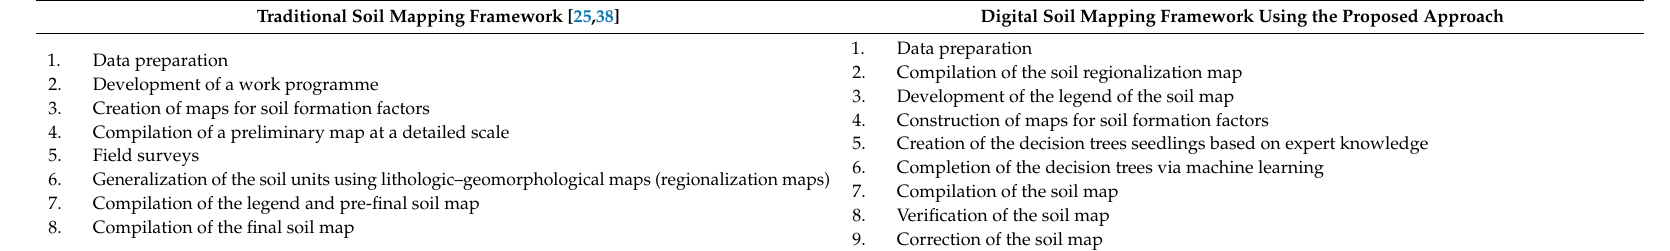
Table 2. Traditional and proposed digital soil mapping frameworks.